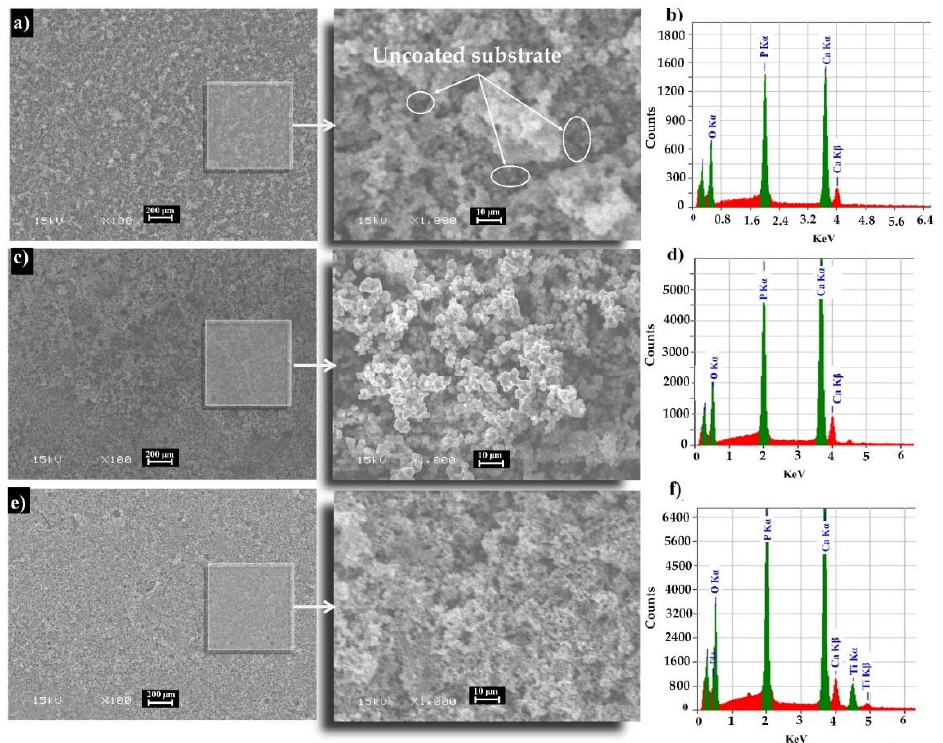
Figure 2. SEM-EDXS analysis of HAP coatings with various amount of H 2 O 2 : ( a , b ) 0%, ( c , d ) 6% and ( e , f ) 9%.